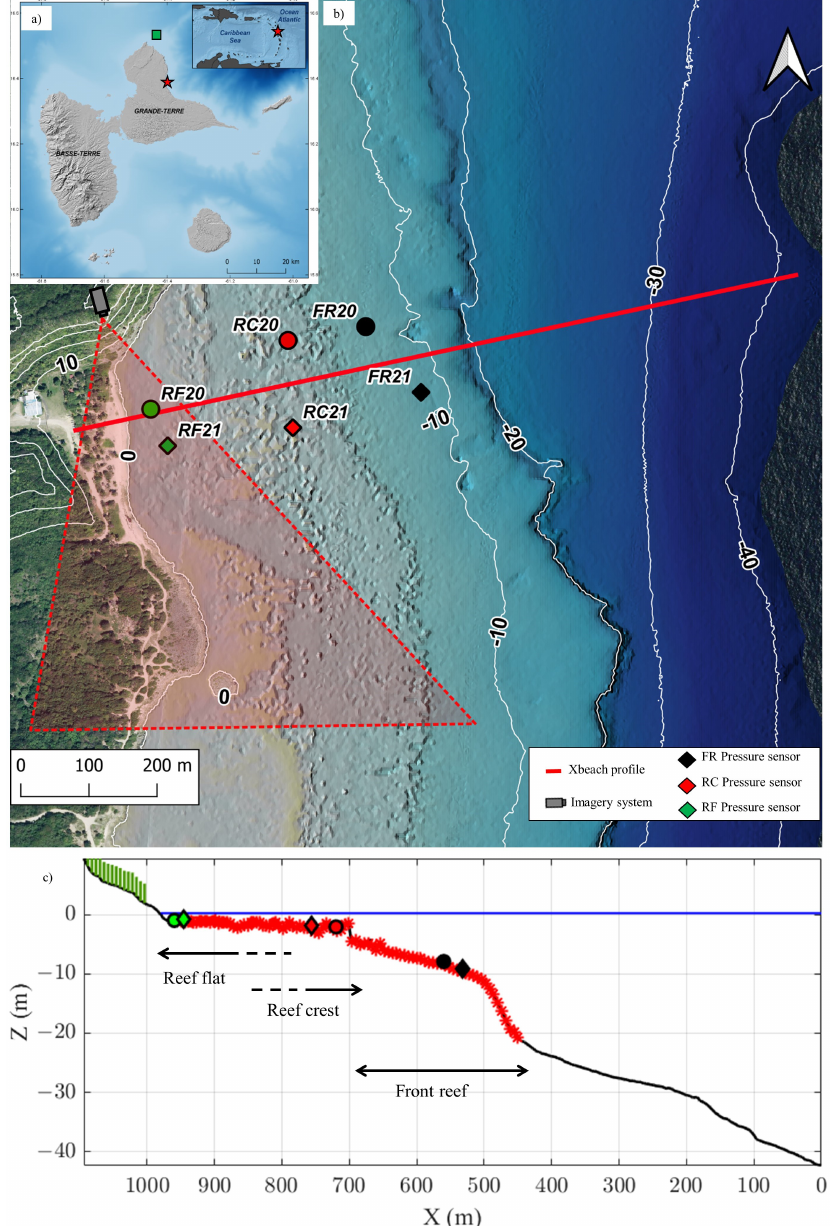
Figure 1. ( a ) Anse-Maurice beach location map ( b ) Map with sensor locations (red, black or green markers), profile line (red line), camera location (grey rectangle), and camera field of view (red area). Beach and nearshore profile ( c ) showing the reef and upperbeach vegetation areas as well as the location of field measurements with pressure